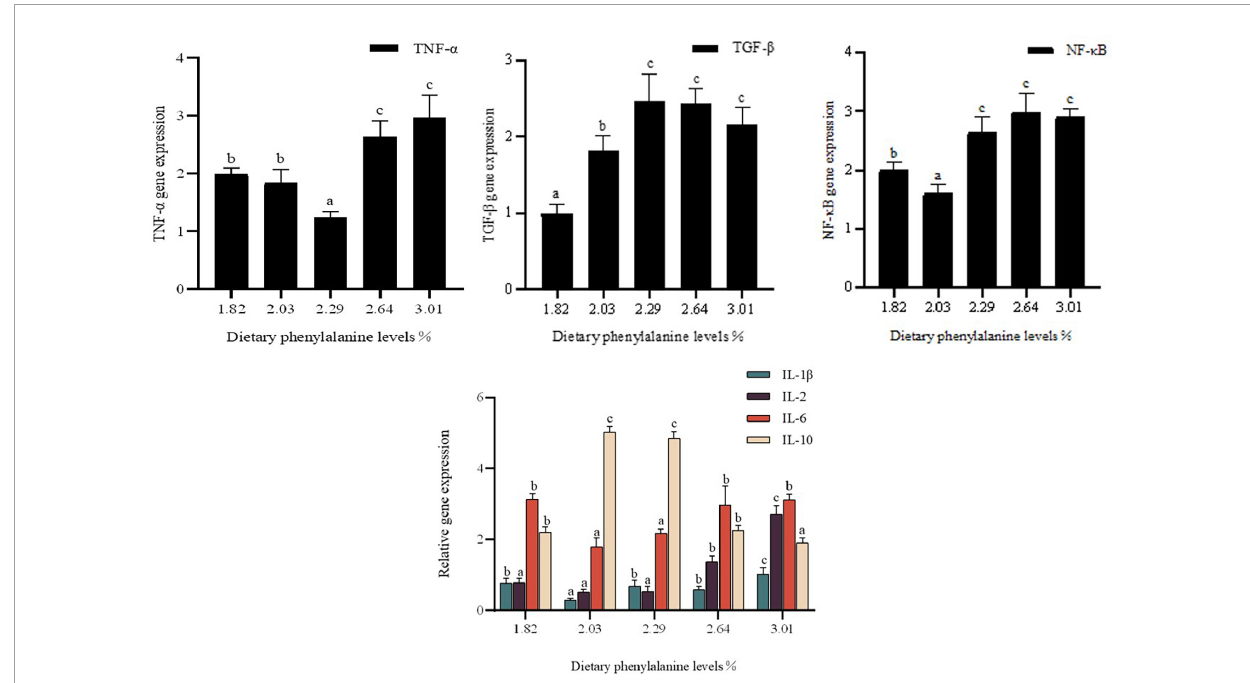
FIGURE5 Immunity gene expression of the intestine. Lowercase letters (a, b, or c) indicate a significant effect of immune-related gene expression in the intestine ( p < 0.05). IL-1 β , interleukin-1 β ; IL-2, interleukin-2; IL-6, interleukin-6; IL-10, interleukin-10; TNF- α , tumor necrosis factor- α ; TGF- β , transforming growth factor- β ; NF- κ B, nuclear transcription